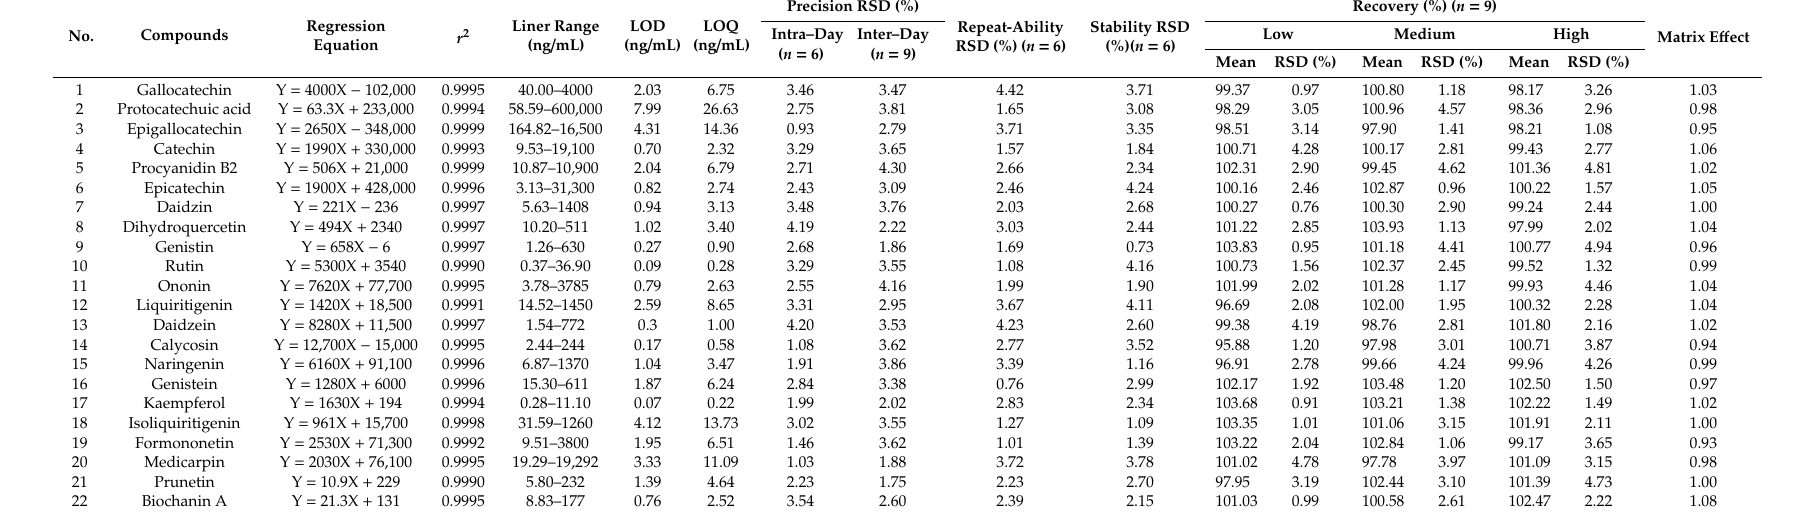
Table 2. Regression equation, limits of detection (LOD) and limits of quantification (LOQ), precision, repeatability, stability and recovery of 22 investigated compounds.